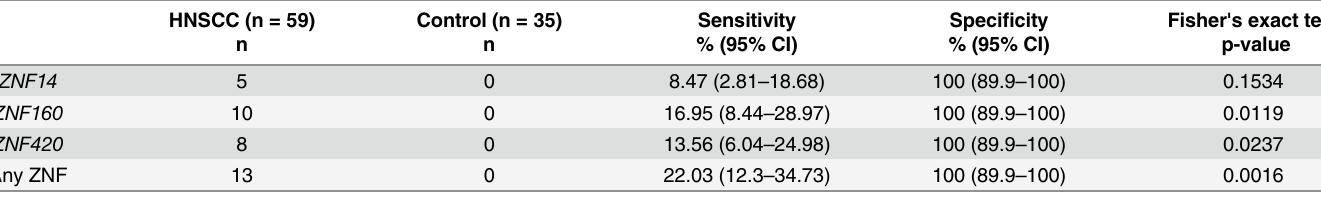
Table 3. Promoter DNA hypermethylation detection in salivary rinses of HNSCC and non-cancerous patients from the validation cohort. HNSCC (n =